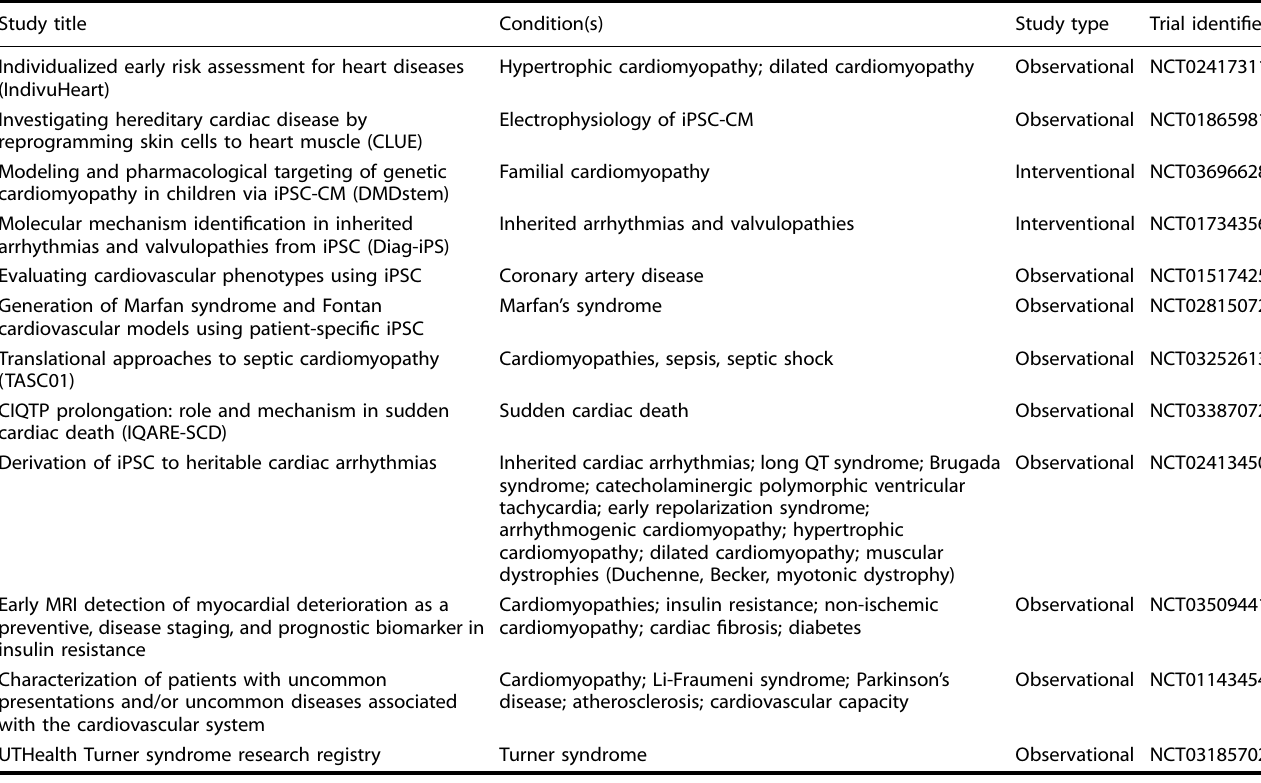
Table 1. Human clinical studies for the generation of disease and/or patient-speci fi c models of cardiac diseases (Trial Identi fi er: www.clinicaltrials.